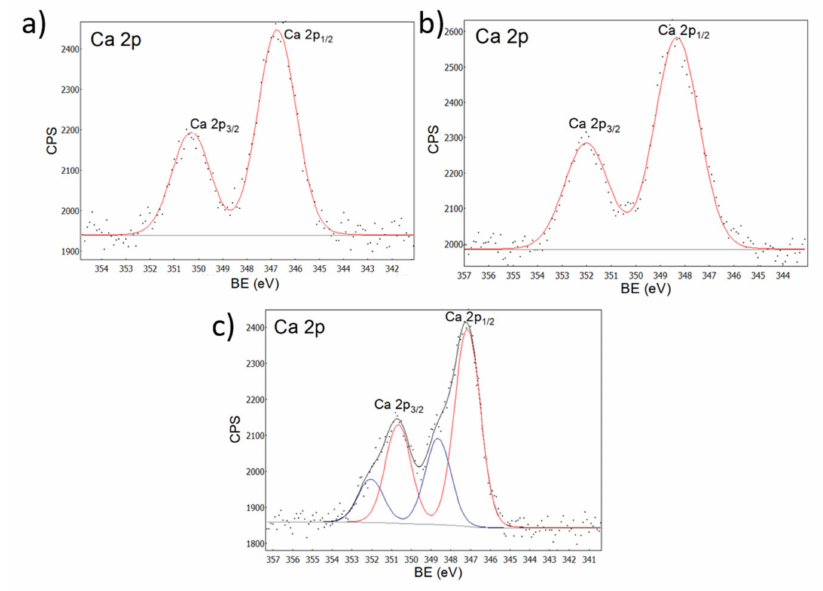
Figure 6. XPS spectra for calcium. ( a ) Zn-Ca 1, ( b ) Zn-Ca 3, ( c ) Zn-Ca